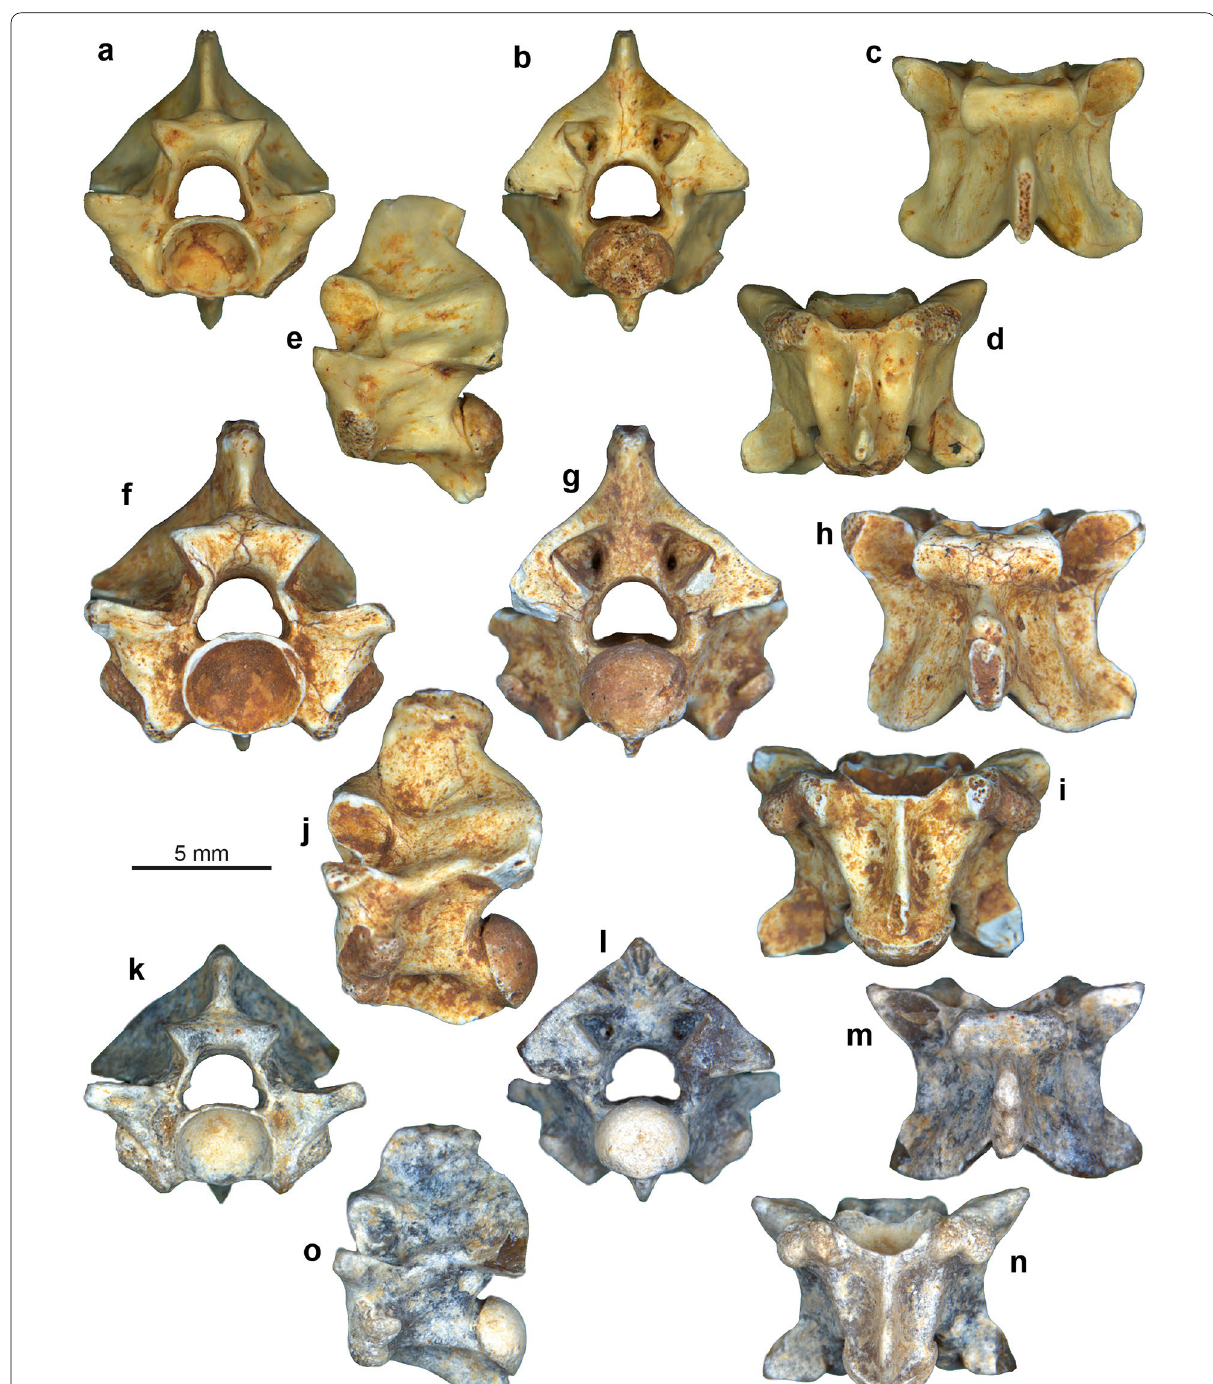
Fig. 44 “ Palaeopython ” neglectus from imprecisely known locality(ies) near Mouillac, Phosphorites du Quercy: a – e anterior trunk vertebra (YPM-VPPU 29859) in anterior ( a ), posterior ( b ), dorsal ( c ), ventral ( d ), and left lateral ( e ) views; f – j anterior trunk vertebra (YPM-VPPU 29857), more posterior than the previous one, in anterior ( f ), posterior ( g ), dorsal ( h ), ventral ( i ), and left lateral ( j ) views; k – o anterior trunk vertebra (YPM-VPPU 30366), more posterior than the previous one, in anterior ( k ), posterior ( l ), dorsal ( m ), ventral ( n ), and left lateral ( o )